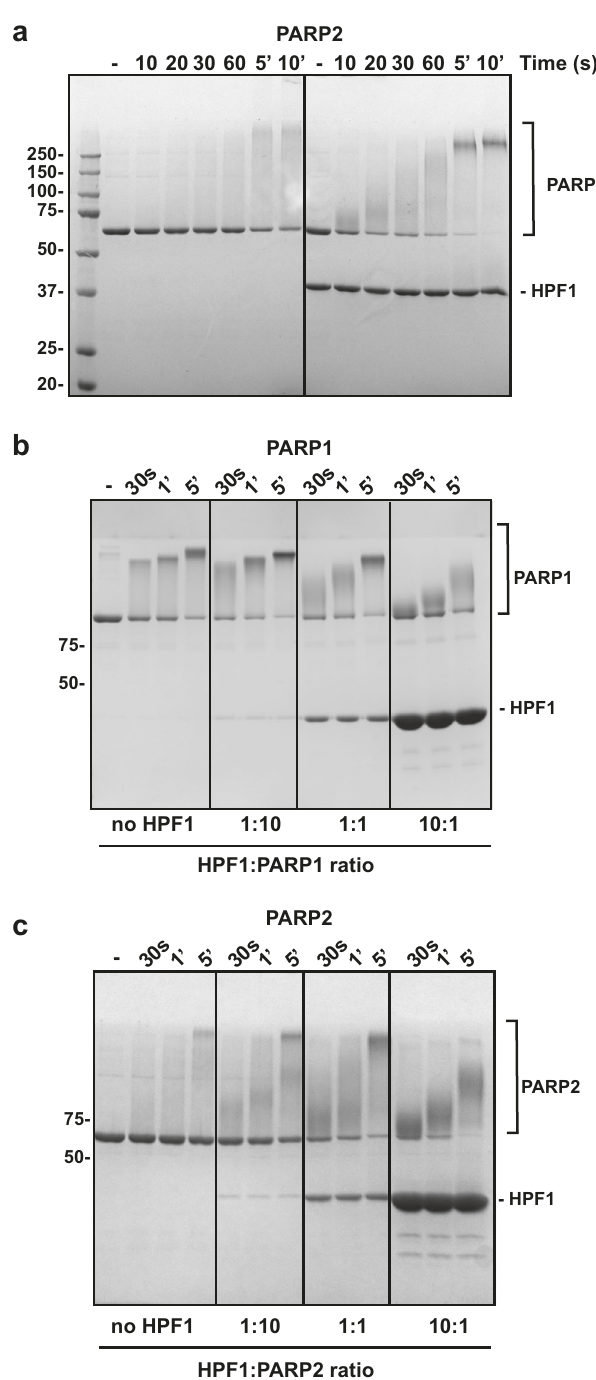
Fig. 4 HPF1 restricts elongation and stimulates initiation in PARP2. a PARP2 (1 μ M) was incubated with HPF1 (1 μ M) for 10 min at RT in the presence of DNA (1 μ M), where indicated. 500 μ M NAD + was added for various time points (except in the “ - ” reaction), and reactions were quenched with SDS-PAGE loading buffer, resolved by SDS-PAGE, and treated with Imperial stain. b PARP1 (1 μ M) was incubated with HPF1 at various ratios as indicated in the presence of DNA (1 μ M) for various time points with 500 μ M NAD + . Reactions were processed as in panel a . c Same as in panel b for PARP2. Experiments in Fig. 4 were performed two times. Numbers on the left side of the gels represent molecular weight marker locations (values in kDa). Source data are provided as a Source Data fi